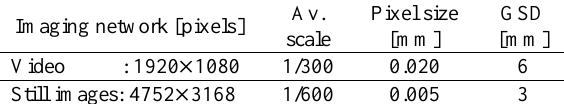
Table 1. The scale and GSD of the video and still imaging networks